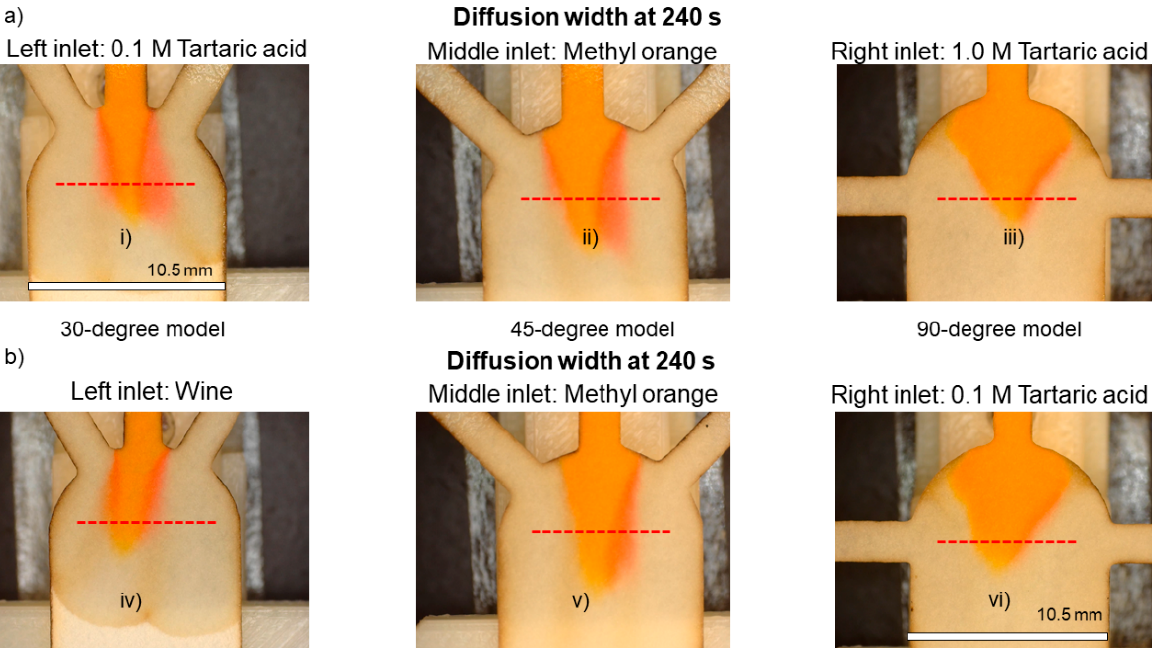
Figure 10. Visual comparison of diffusion development in different models. Measurement line is displayed as the dashed line.